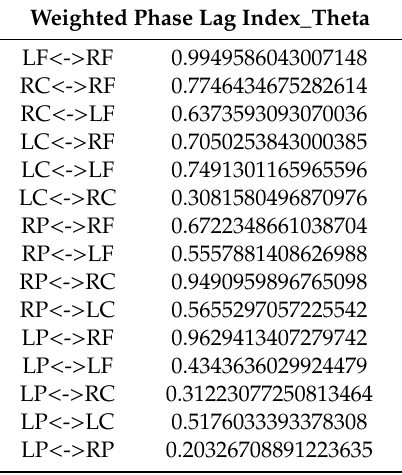
Table A3. p -Values Obtained for the Weighted Phase Lag Index Connectivity Analysis in the Theta